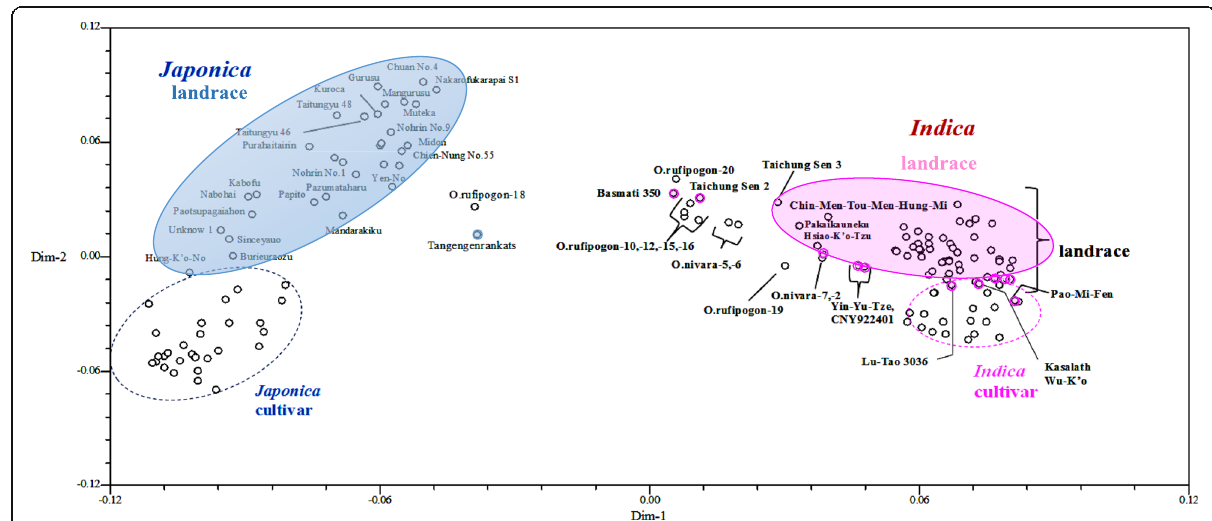
Fig. 1 Principle coordinate analysis (PCoA) of 148 rice accessions. After 2-dimension analysis of PCoA, the first and second dimension explained 18.1% and 7.7%, respectively. Each accession is indicated by a circle. Japonica and indica rices are distinctly separated, with japonica and indica landraces indicated by blue and magenta solid ellipses, and japonica and indica cultivars indicated by blue and magenta dashed ellipses,